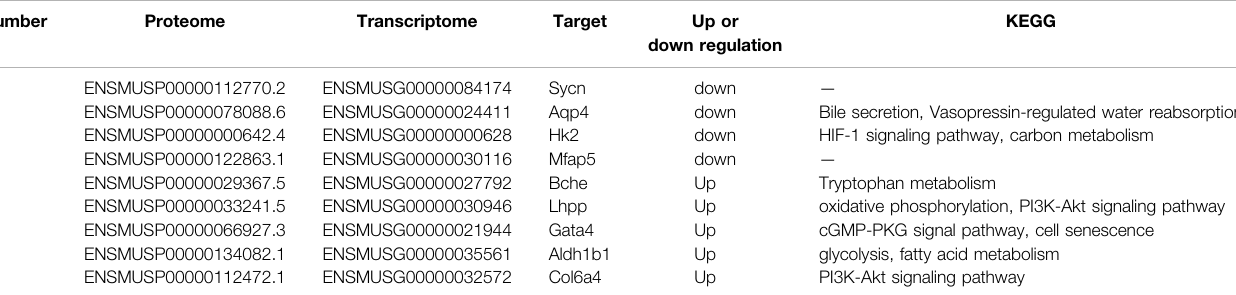
TABLE 3 | Differential targets obtained by cross-analysis of transcriptome and proteome.